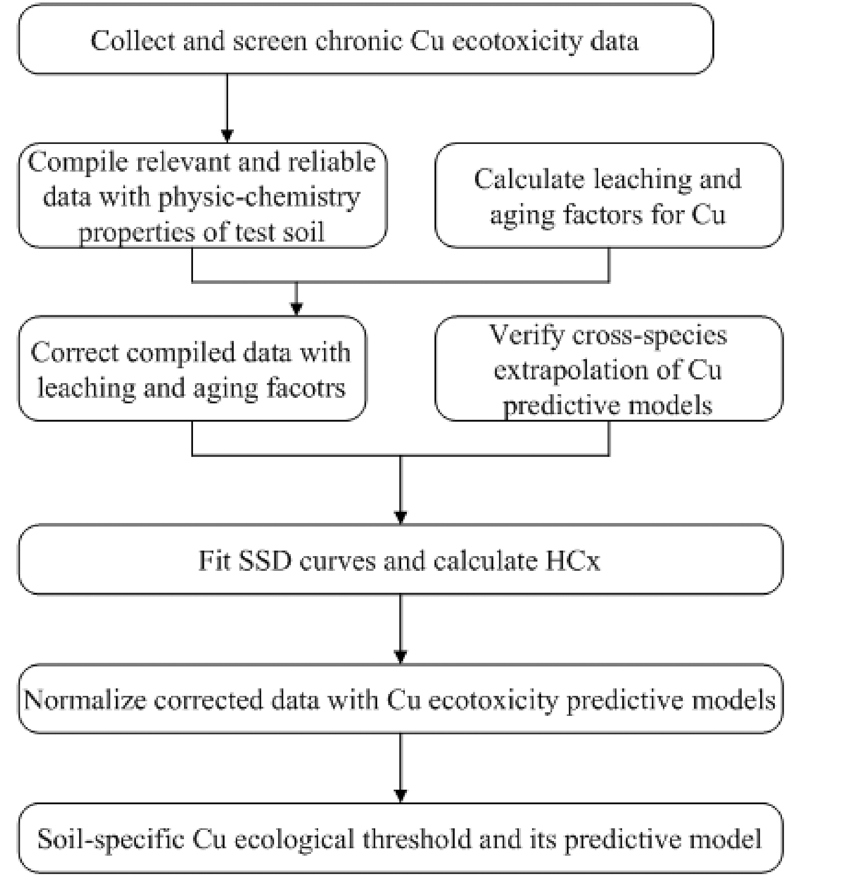
Fig 1. Schematic framework used for derivation of soil Cu ecological